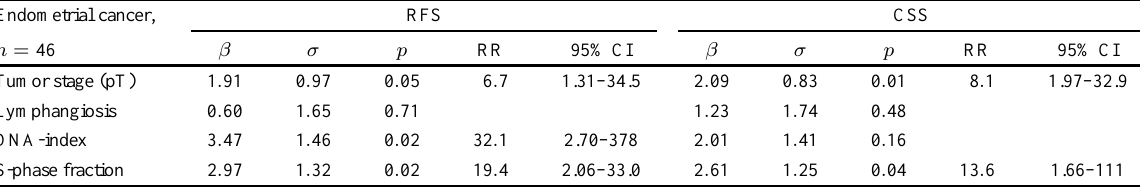
Primary endometrial cancer ( n = 46). Cox-multivariate analysis of univariate prognostic relevant parameters for recurrence-free survival (RFS) and tumor-dependent overall survival (CSS). For all parameters multivariate analysis were performed. For all parameters the value of effect